Question: Which kind of chart has been used to present this data?
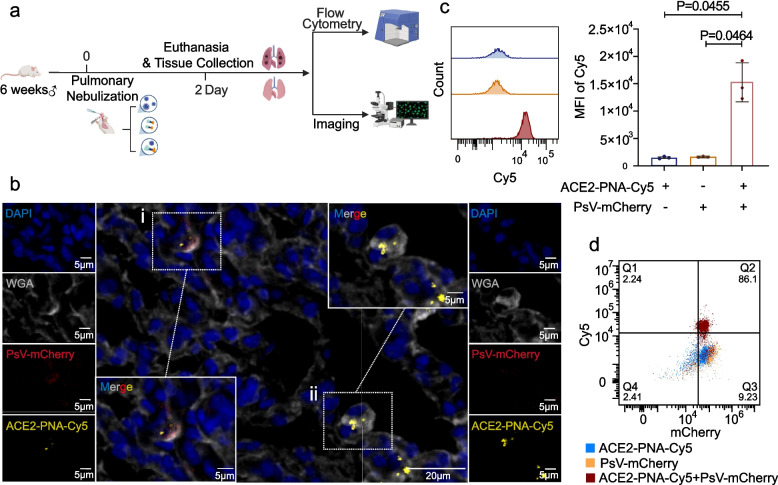
Answer: scatter